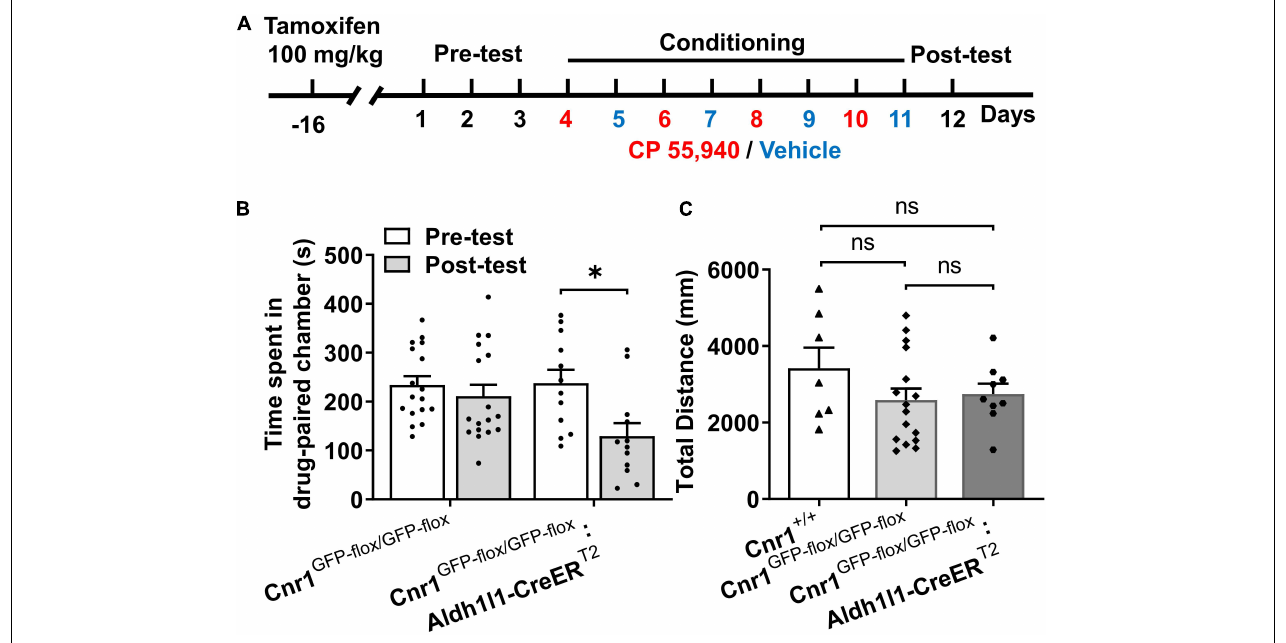
FIGURE 4 | The CP 55,940 induces conditioned place aversion (CPA) in Cnr1 GFP - flox / GFP - flox : Aldh1l1 -CreER T2 , but not CPA Cnr1 GFP - flox / GFP - flox mice treated with tamoxifen. (A) The conditioned place preference (CPP) procedure for conditional transgenic mice was performed 10 days after the last injection of tamoxifen (100 mg/kg, once a day for seven consecutive days). (B) Cnr1 GFP - flox / GFP - flox : Aldh1l1 -CreER T2 , but not Cnr1 GFP - flox / GFP - flox mice showing conditioned place aversion effect of CP 55,940. ∗ P < 0.05 (one-way ANOVA, Welch and Brown–Forsythe test). (C) Distances traveled in the CPP apparatus for Cnr1 + / + , Cnr1 GFP - flox / GFP - flox , and Cnr1 GFP - flox / GFP - flox : Aldh1l1 -CreER T2 mice. ns, not statistically significant (Student’s unpaired t -test).